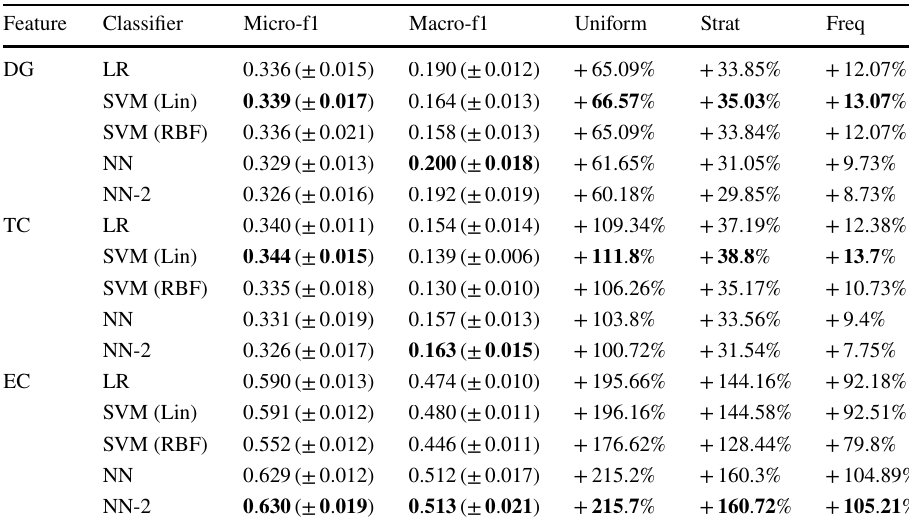
Table 5 Degree (DG), triangle count (TC) and eigenvector centrality (EC) classification results for SDNE embeddings on the ego-Facebook dataset